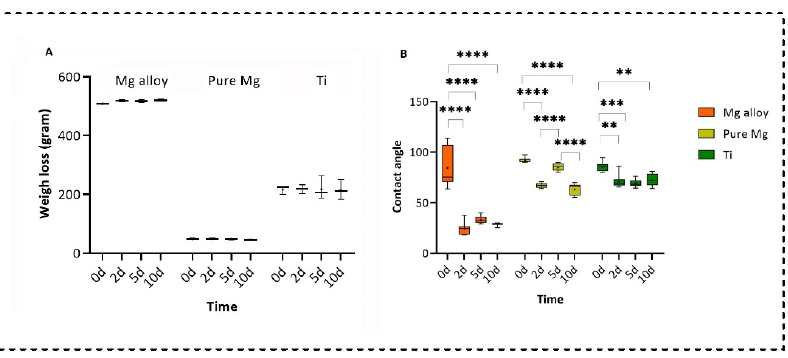
Figure 7. Analysis of ( A ) weight loss and ( B ) contact angle measurements (two-way ANOVA post hoc Tukey method with statistically significant difference of **** p < 0.0001, *** p < 0.001, ** p < 0.01, * p < 0.05).